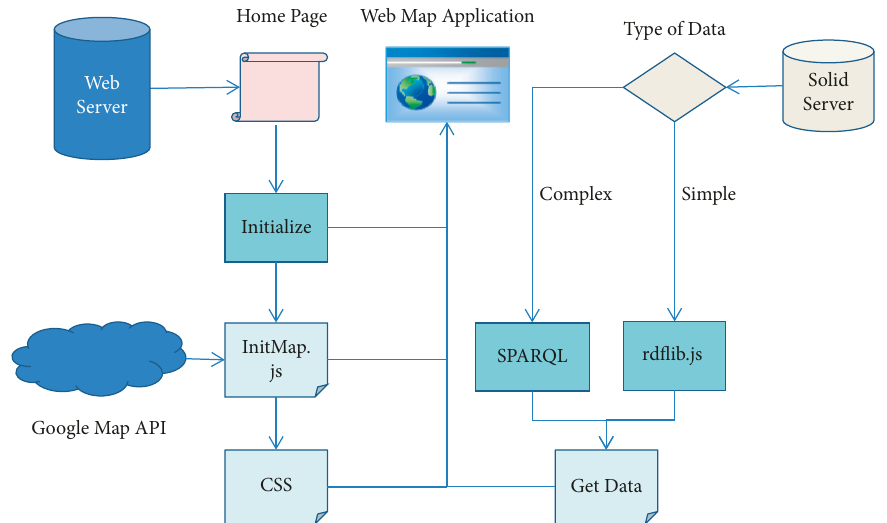
Figure 6: Visualization framework of implementing web-based data-sharing system.